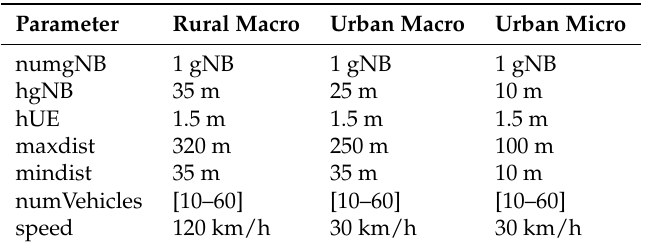
Table 3. Parameters of 5G V2X scenarios.